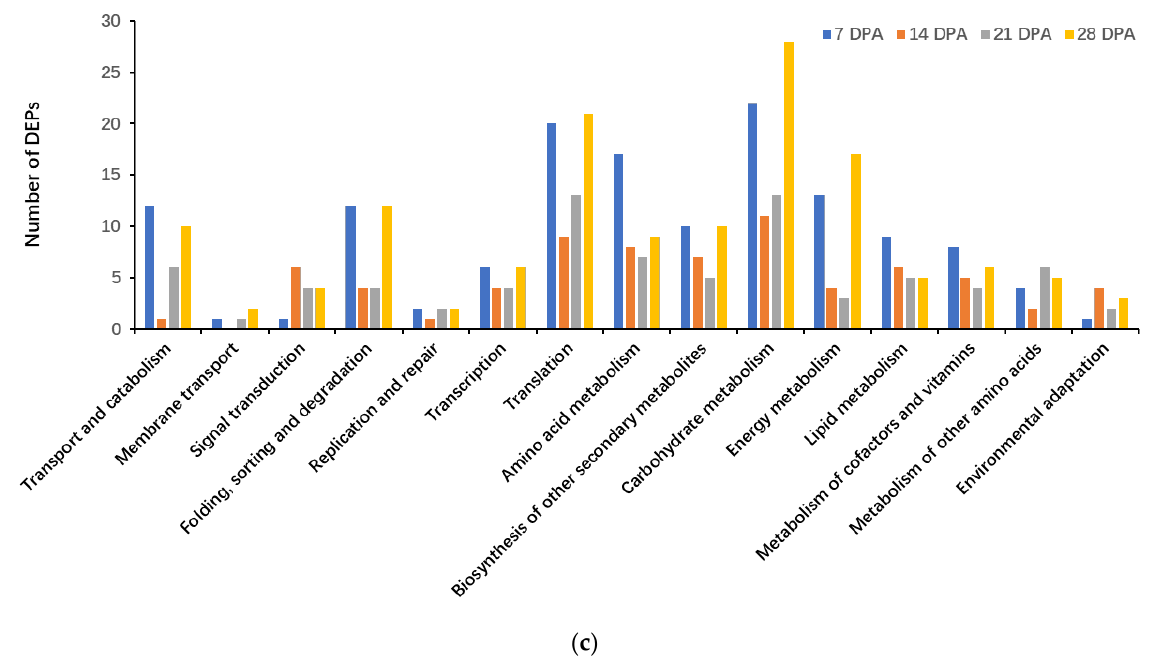
Figure 1. GO and KEGG enrichment results. ( a ) GO enrichment results from both transcriptomic and proteomic data at 21 DPA. ( b ) KEGG enrichment results at 21 DPA from the transcriptomic data. ( c ) KEGG enrichment results at 7, 14, 21, and 28 DPA from the proteomic data. In total, 621 proteins were differentially expressed (Supplementary Table S2). Among the four different stages, more DEPs were observed at 7 and 28 DPA (232 and 228) com- Table 2. Commonly identified genes from both transcriptome and proteome at different stages.